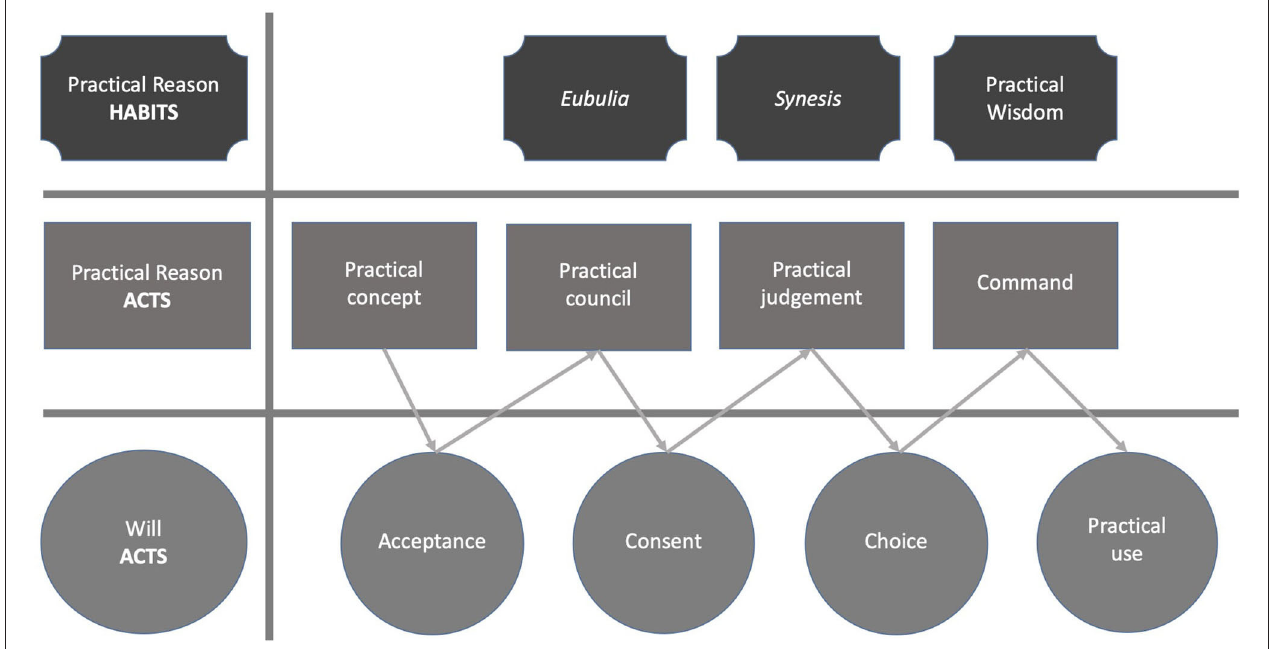
FIGURE 1 | Practical reason and will: acts and